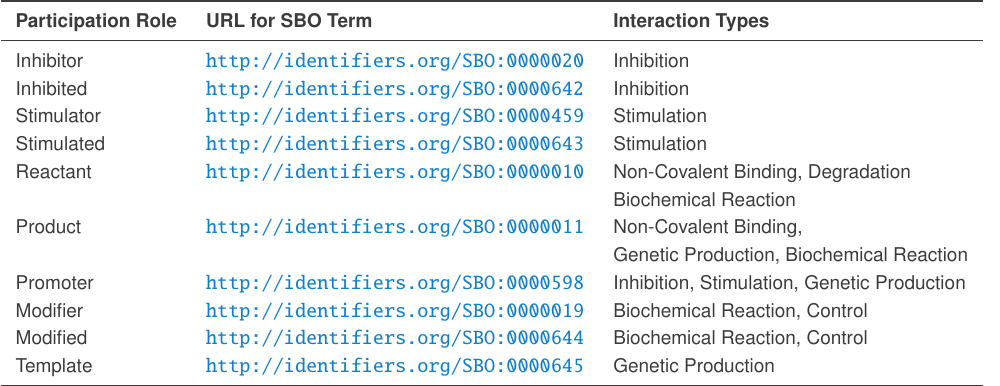
Table 12: Partial list of SBO terms to specify the role properties of a Participation .